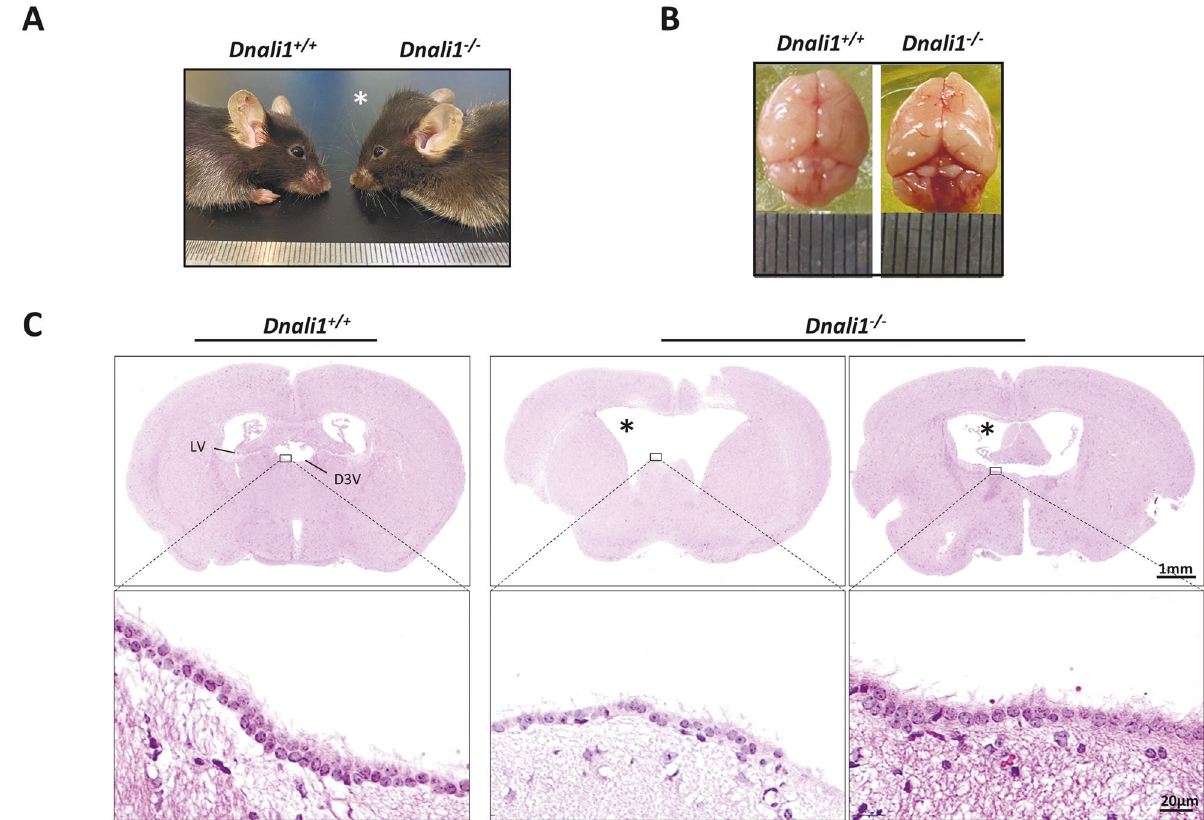
Fig. 7 Dnali1 − / − mice have distinct hydrocephalus. A Representative lateral images of 8-week-old Dnali1 − / − mice with a domed cranial vault, compared to the Dnali1 + / + mice. B The top view of the whole skulls from the Dnali1 + / + and Dnali1 − / − mice. C The coronal mice brain sections stained with H&E. High magni fi cation images reveal that cilia are present on intact Dnali1 − / − ependyma. D3V dorsal 3rd ventricle, LV lateral ventricle. The asterisk indicates the enlarged